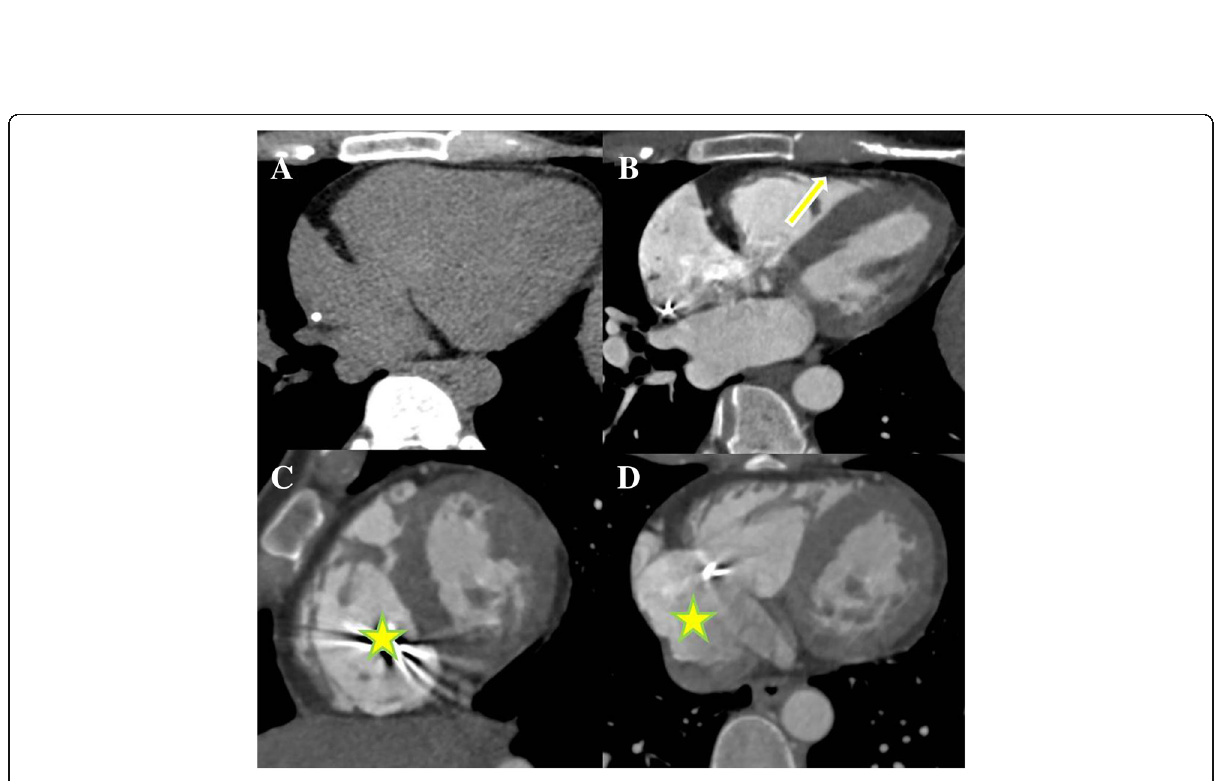
Fig. 3 Cardiac CT images of III:1 patient. Four-chamber view of non-enhanced image ( a ) and enhanced image ( b ). Thinning of the anterior wall of the right ventricle with extensive fatty infiltration (arrow) could be noted. The short-axis view ( c ) demonstrated dilation of the right ventricle (star). Enlargement of the right atrium (stars) was shown on the axial view ( d